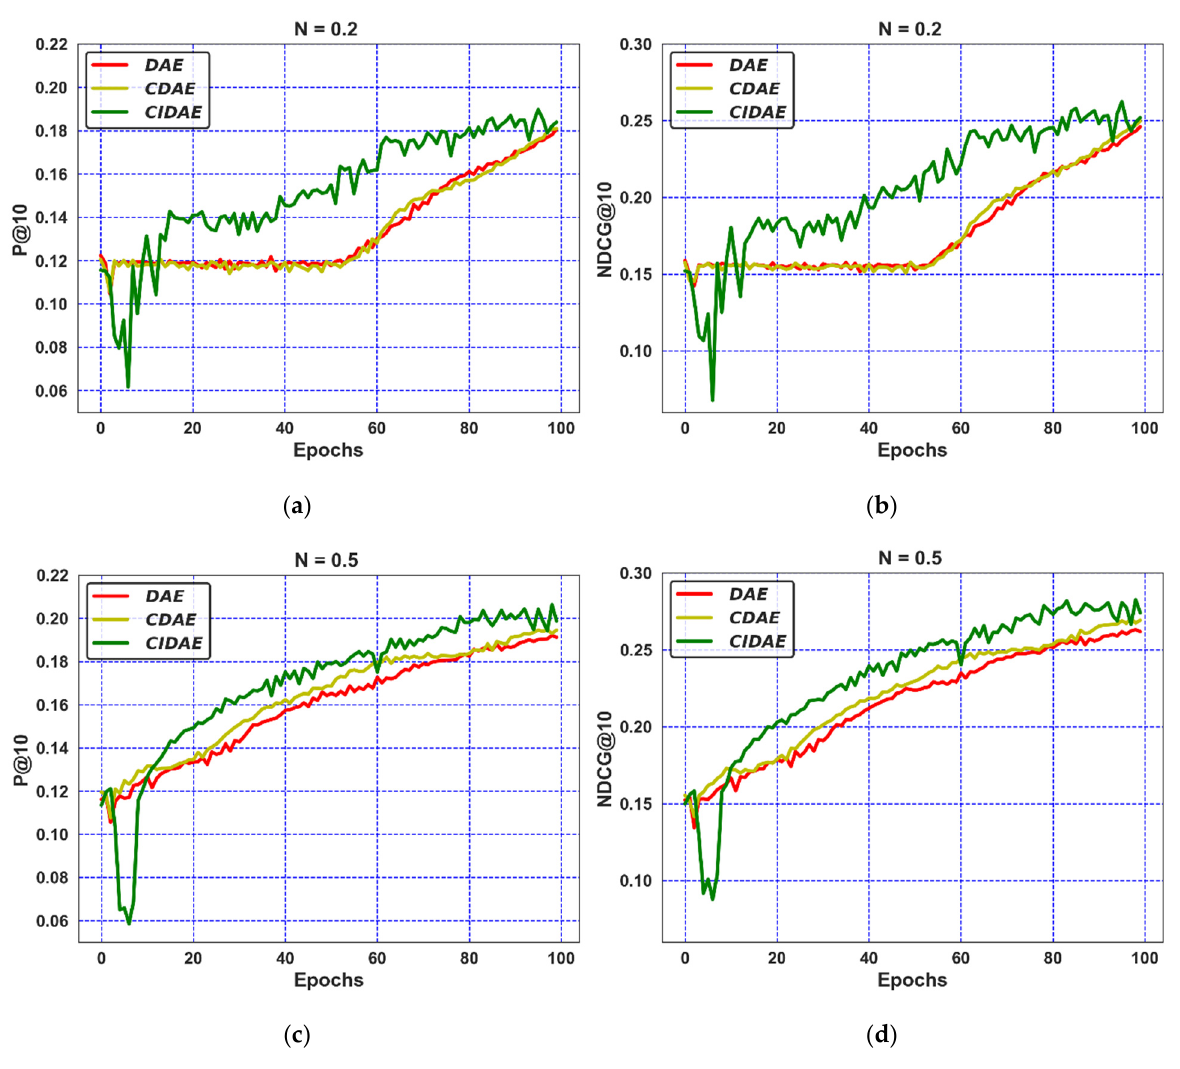
Figure 8. Performance comparison on ML ‐ 100K through P@10 and NDCG@10